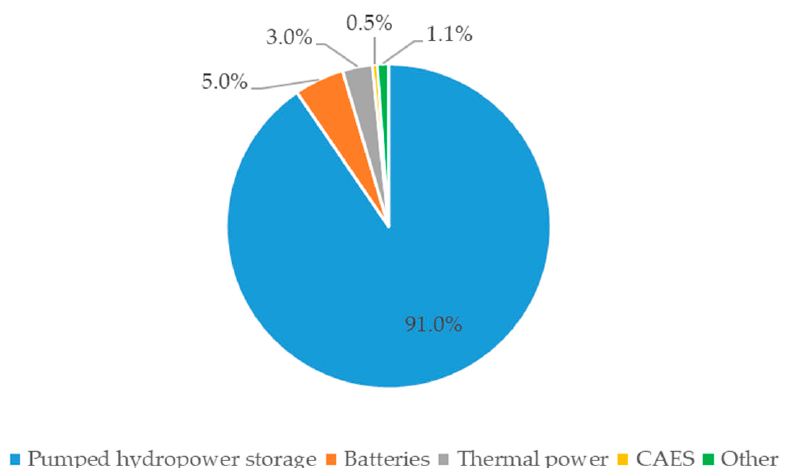
Figure 1. Installed capacity from energy storage technologies, 2019. Source: IEA. To date, many types of redox flow batteries have been proposed depending on the redox couples used. All-vanadium [8,9], zinc-bromine [10,11], all-iron [12], semi-solid lithium [13] and hydrogen-bromine [14] are some of the most common types of redox flow batteries (RFB) that can be found in the literature. Since Skyllas-Kazacos et al. [15,16] sug- gested a Vanadium Redox Flow Battery (VRFB) in 1985, this electrochemical energy storage device has experimented a major development, making it one of the most popular flow batteries these days [17]. Flow batteries are a remarkable option for the large-scale energy storage issue due to their scalability, design flexibility, long life cycle, low maintenance and good safety systems [18,19]. Table 1 summarizes the main characteristics of flow batteries as well as other type of energy storage systems. It is important also to highlight the main advantages that flow batteries offer